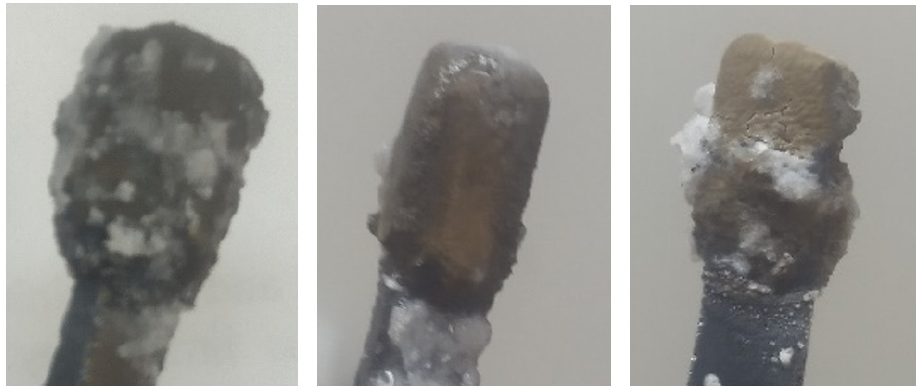
Figure 2. Photographs of the cathode deposits obtained after the electrolysis of the KCl–K 2 SiF 6 melt at a temperature of 790 ° С and cathode overvoltage of 0.25, 0.15, and 0.1 V vs. QRE potential.